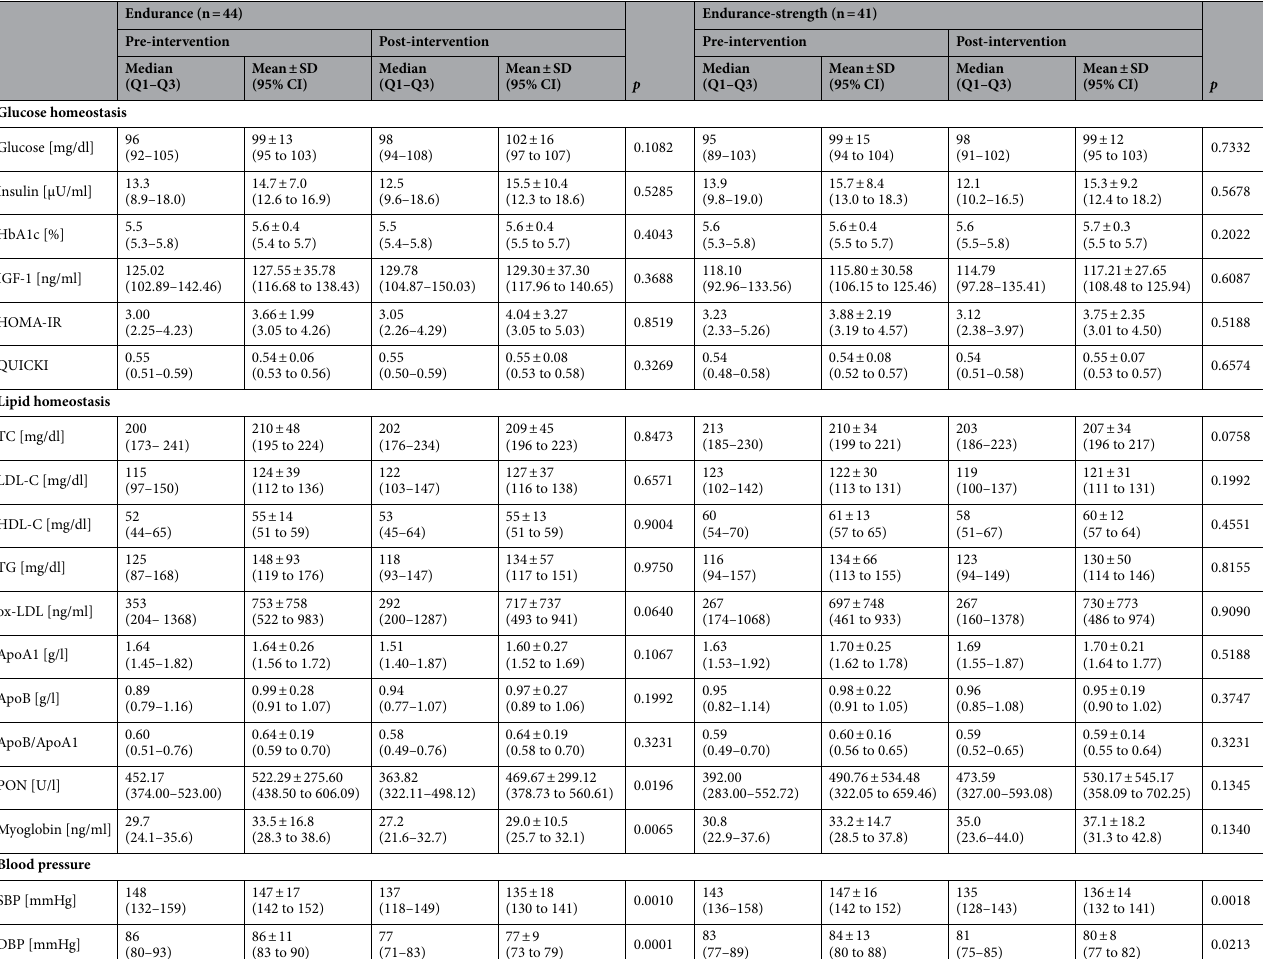
Table 4. Effects of endurance and endurance-strength training on metabolic parameters and blood pressure. ApoA1 apolipoprotein A1, ApoB apolipoprotein B, DBP diastolic blood pressure, HbA1c glycated haemoglobin, HDL-C high-density lipoprotein cholesterol, HOMA homeostatic model assessment for insulin resistance, IGF-1 insulin-like growth factor, LDL-C low-density lipoprotein cholesterol, ox-LDL oxidized low-density lipoprotein, PON paraoxonases, SBP systolic blood pressure, TC total cholesterol, TG triglycerides, QUICKI quantitative insulin sensitivity check